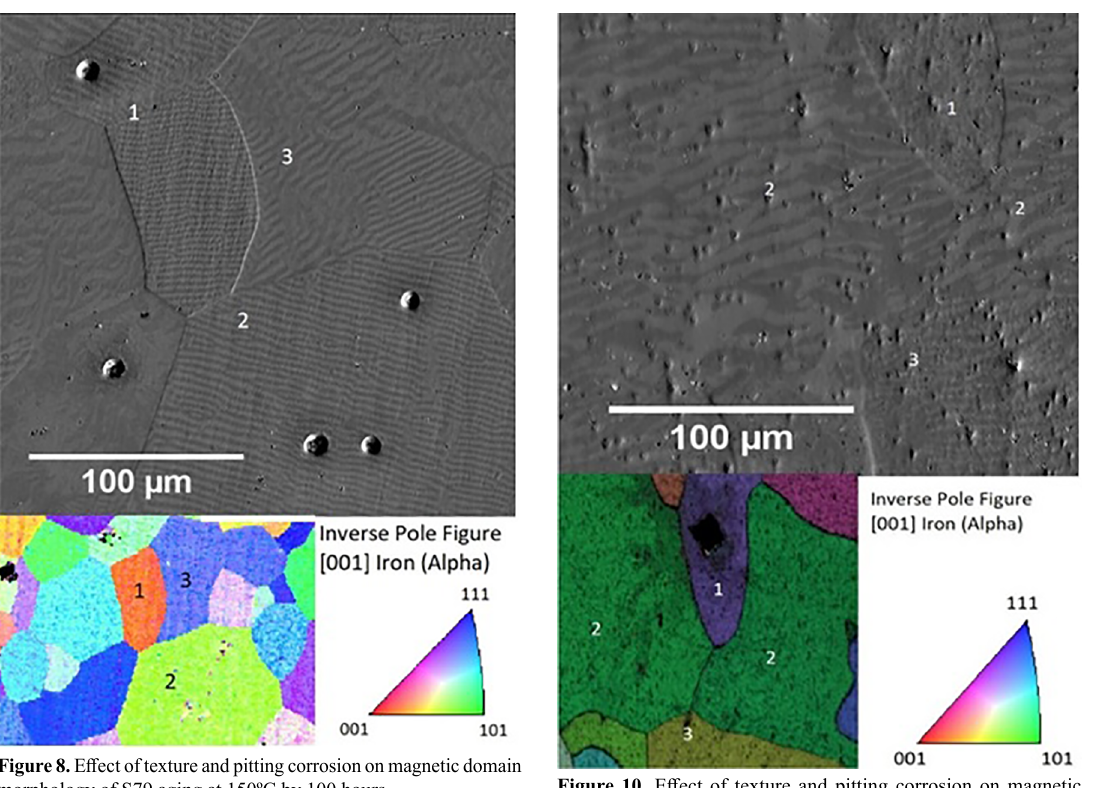
Figure 10. Effect of texture and pitting corrosion on magnetic domain morphology of S340 aging at 150ºC by 100 hours. a nucleation of new domains walls under an absence of external